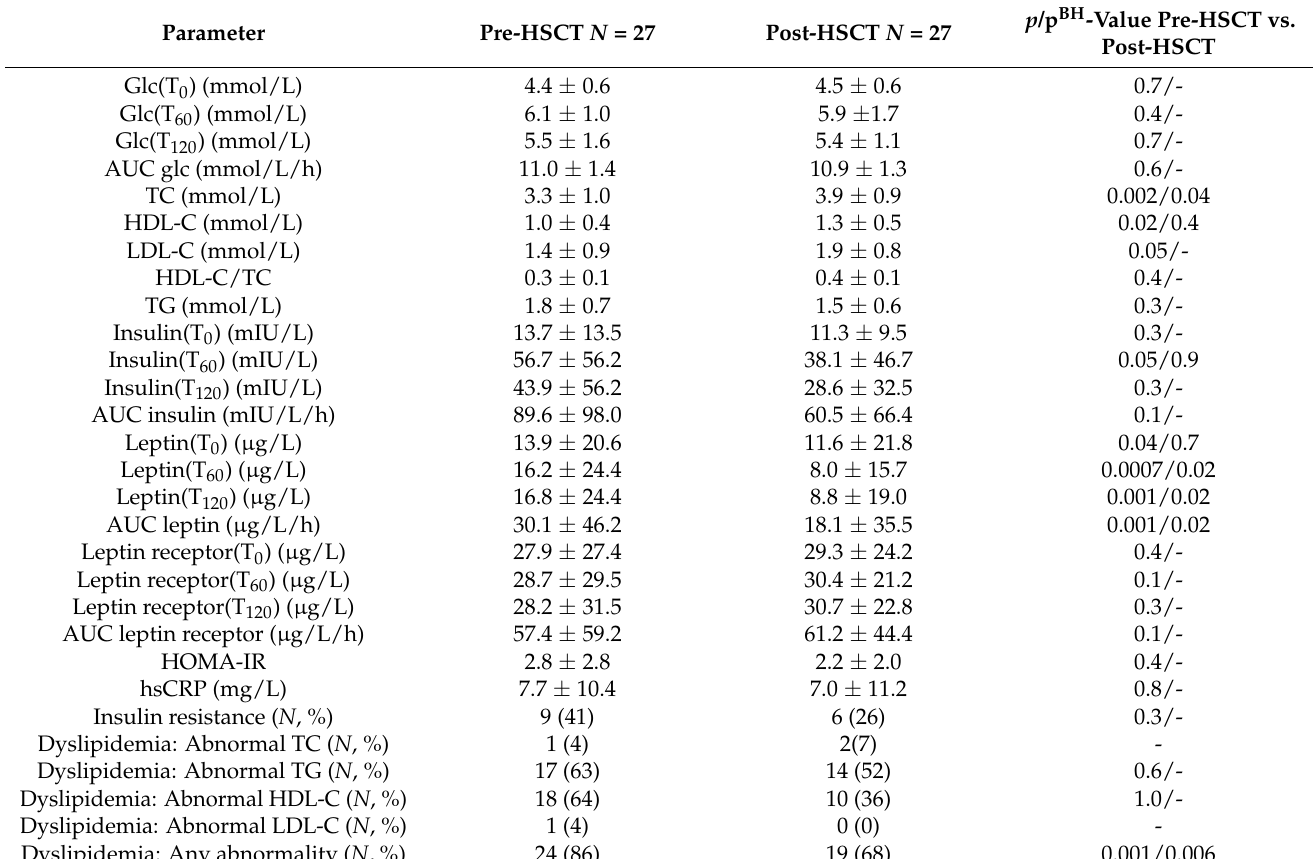
Table 5. Results of laboratory analysis in children with HSCT